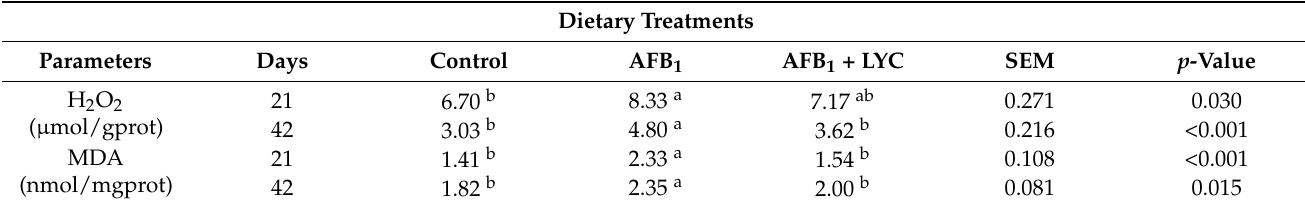
Table 4. Effects of LYC on oxidative status in the broiler jejunum fed AFB 1 contaminated diet at 21 and 42 d. Dietary Treatments